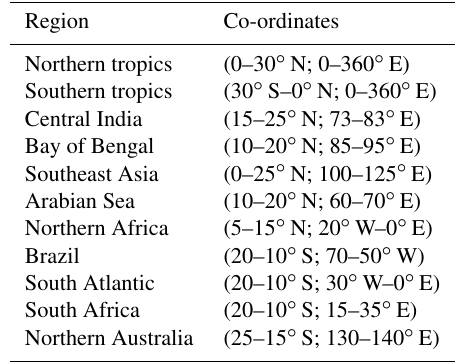
Table 2. The regions used in this article and their coordinates.